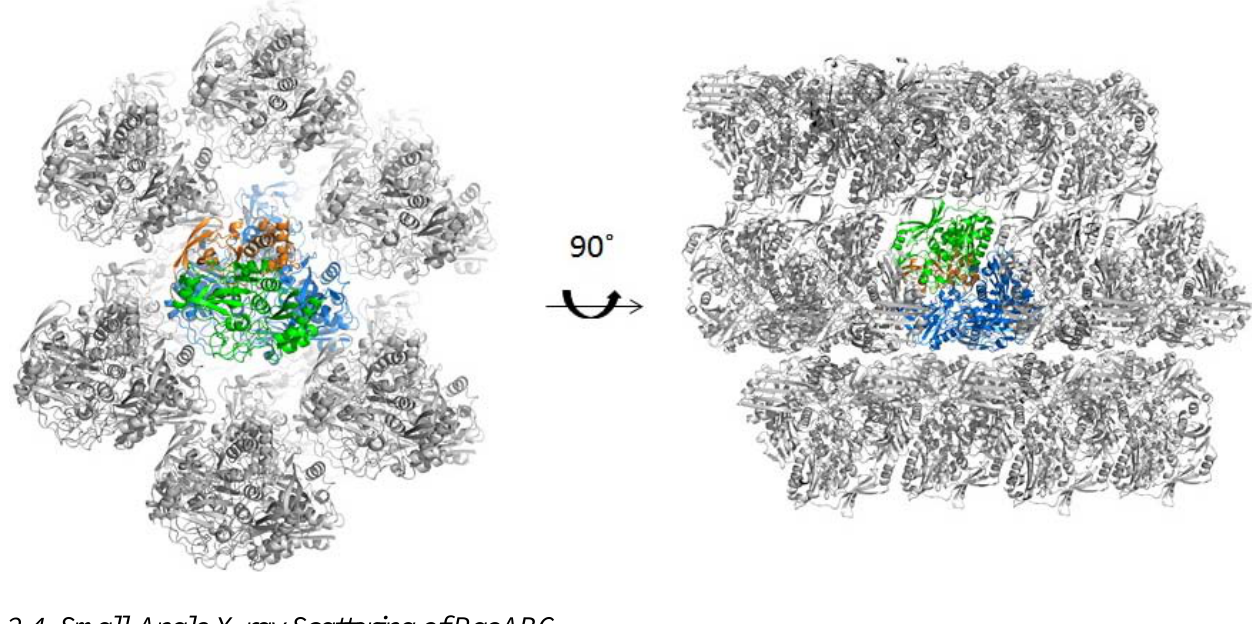
Figure 2. Crystal packing of PaoABC. Cartoon representation of several asymmetric units of PaoABC untwinned crystals with subunit A in orange, B in green and C in blue when viewed along the c axis and rotated 90°. Picture prepared using PyMOL 1.5.0.3